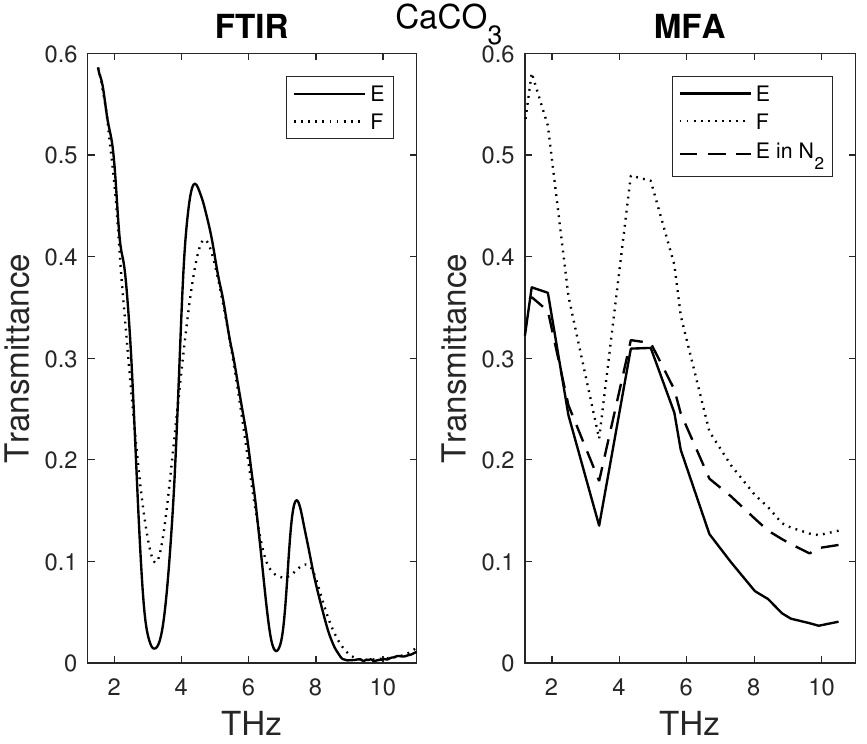
Figure 4. Comparison on two samples C and D of CaCO 3 using FTIR ( left ) or filter ( right